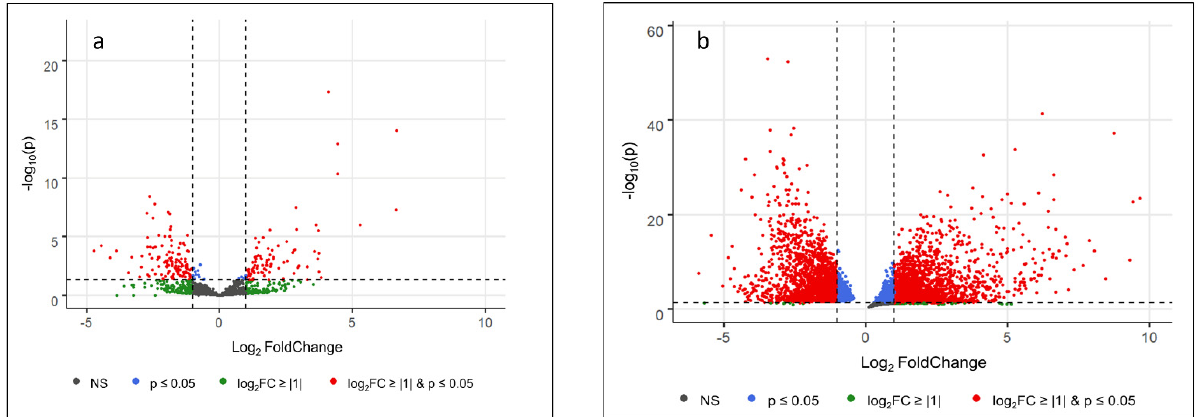
Figure 1. Volcano plots of miRNA ( a ) and mRNA ( b ) regulation from RNAseq. Dashed lines: significance thresholds for log2 fold change and p -value. NS: not significant; log2FC: log2 fold change.